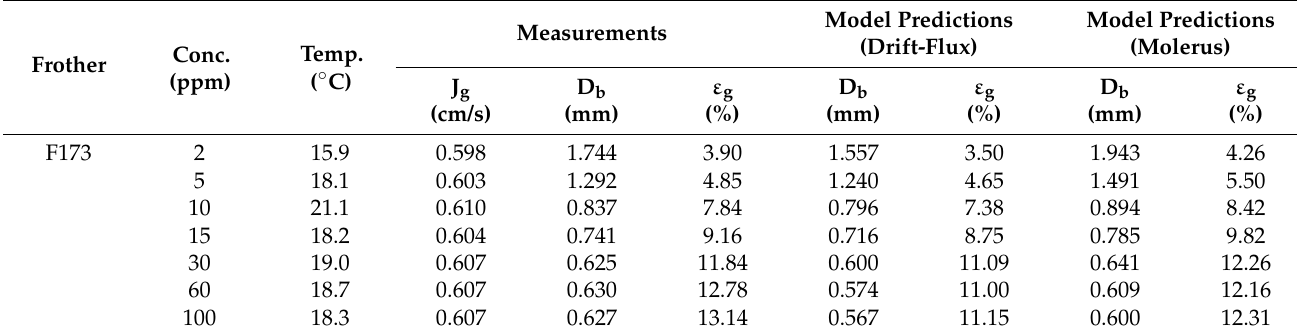
Figure 9. Predicted vs. measured bubble size (Molerus model).